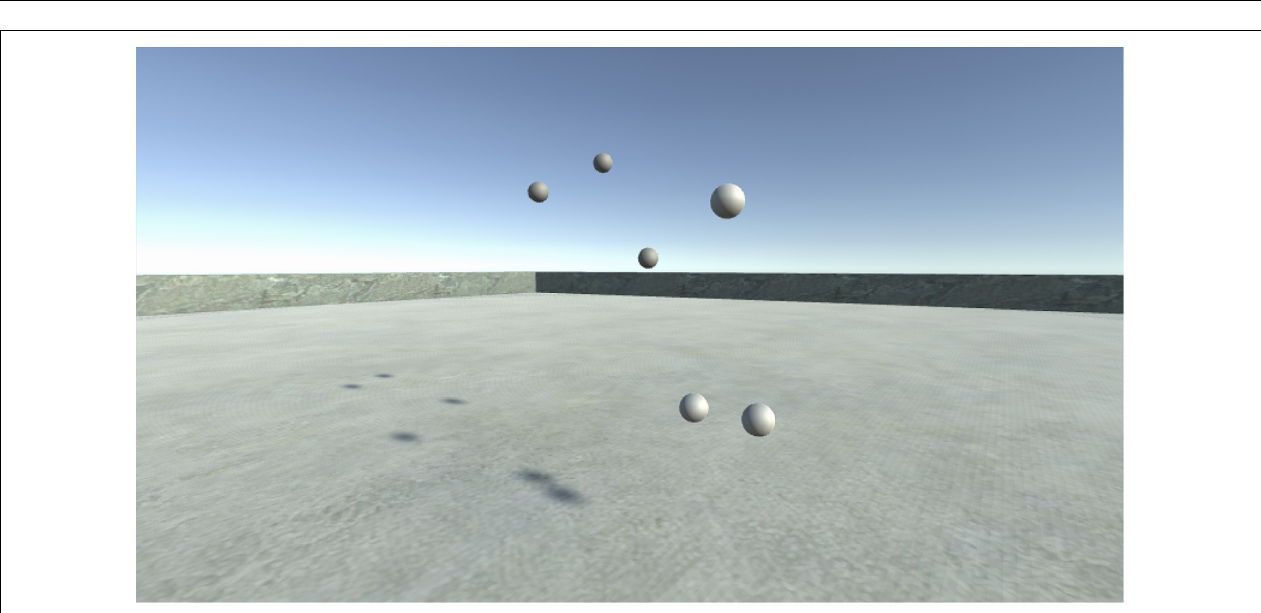
FIGURE 1 | Graphic illustration of the Articulations setup: the two participants are in separate squares but share the same virtual space. HTC Vive lighthouses are installed around the movement space and provide the headsets with localization information. The data is then processed by two dedicated computers, connected via a server program installed on a third computer, that render the virtual scene.